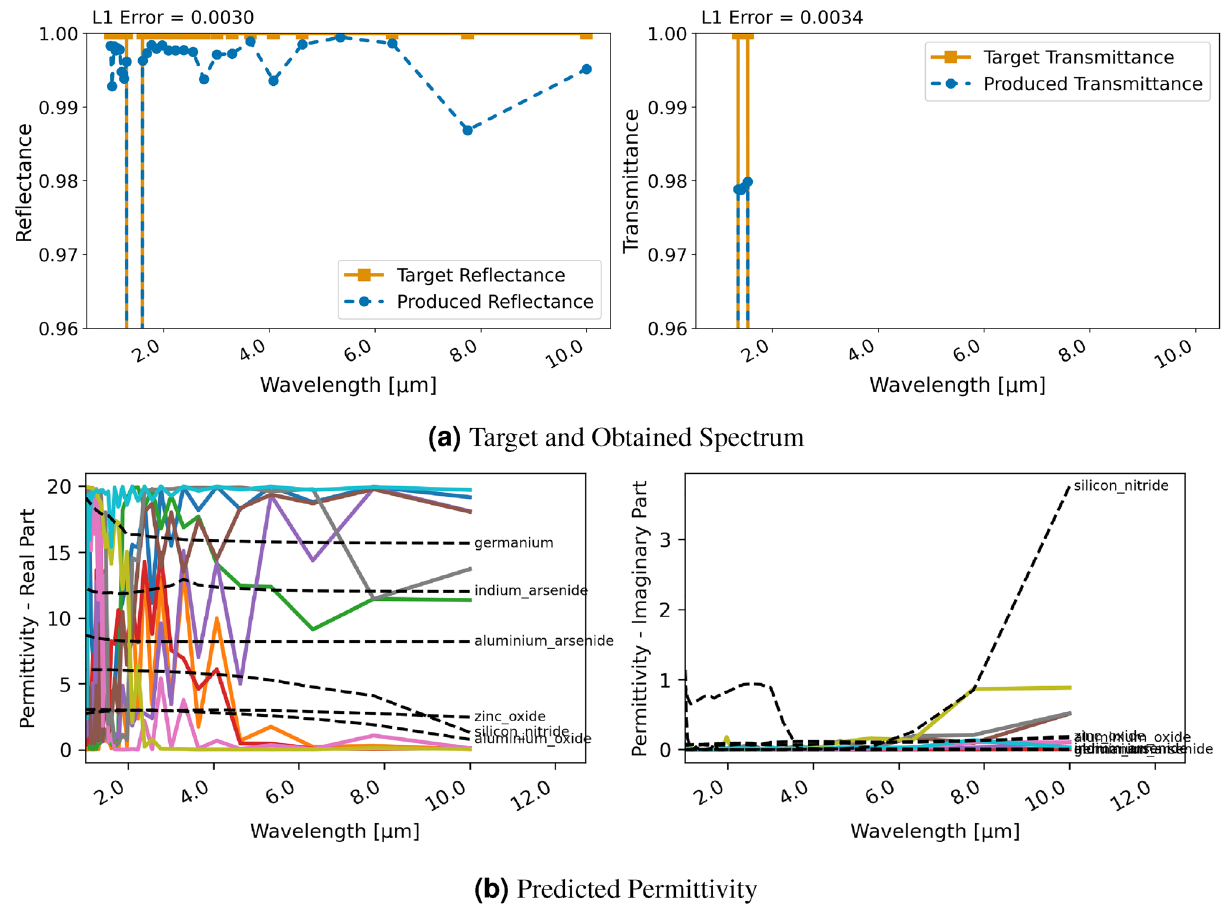
Figure 9. Inversion results for designing a bandpass filter with a ten layer stack using RCWA and regression; ( a ) displays target and produced spectra, ( b ) shows the utilized permittivity for each layer and closest material in NIDN